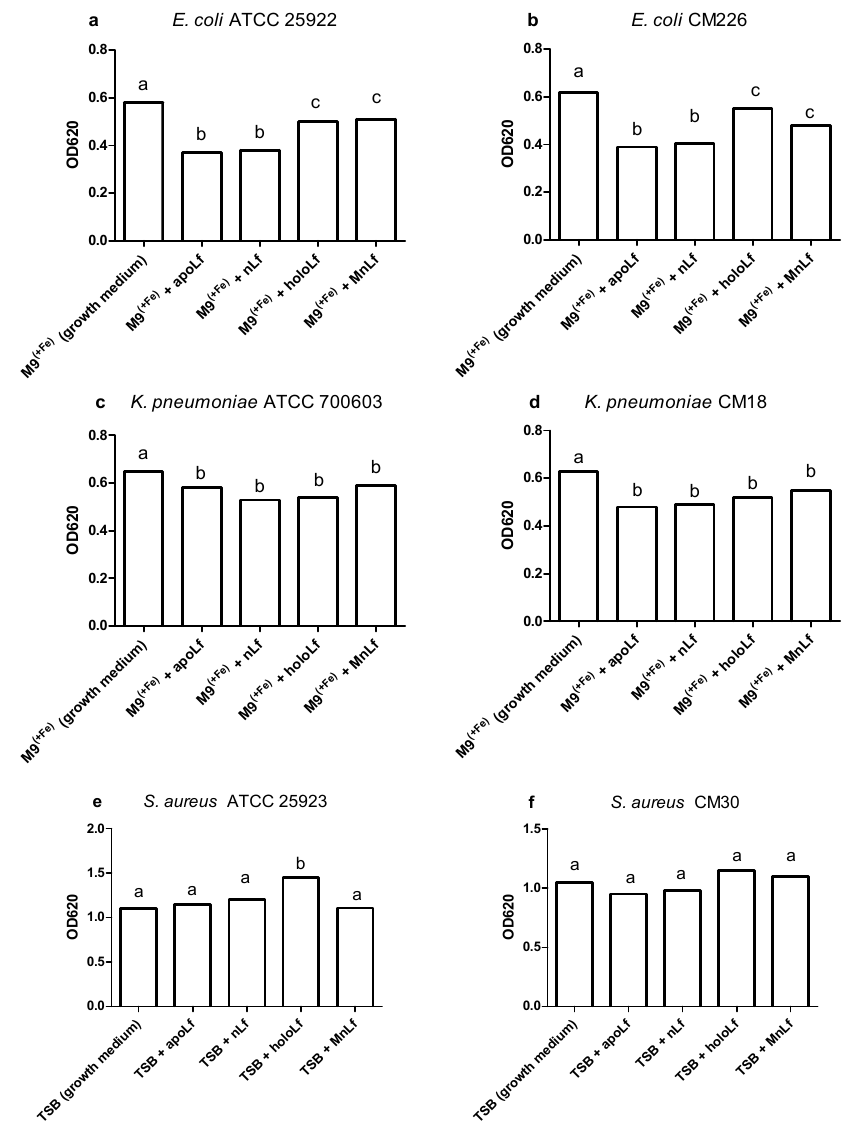
Figure 2. Optical density of pathogenic bacteria cultures after 24 h culture in the presence of various lactoferrin forms. E. coli ATCC 25922 ( a ), E. coli CM226 ( b ), K. pneumoniae ATCC 700603 ( c ), K. pneumoniae CM18 ( d ), S. aureus ATCC 25923 ( e ), S. aureus CM30 ( f ). All of the observed differences (bars without a common letter) were significant at p < 0.001 in one-way ANOVA.